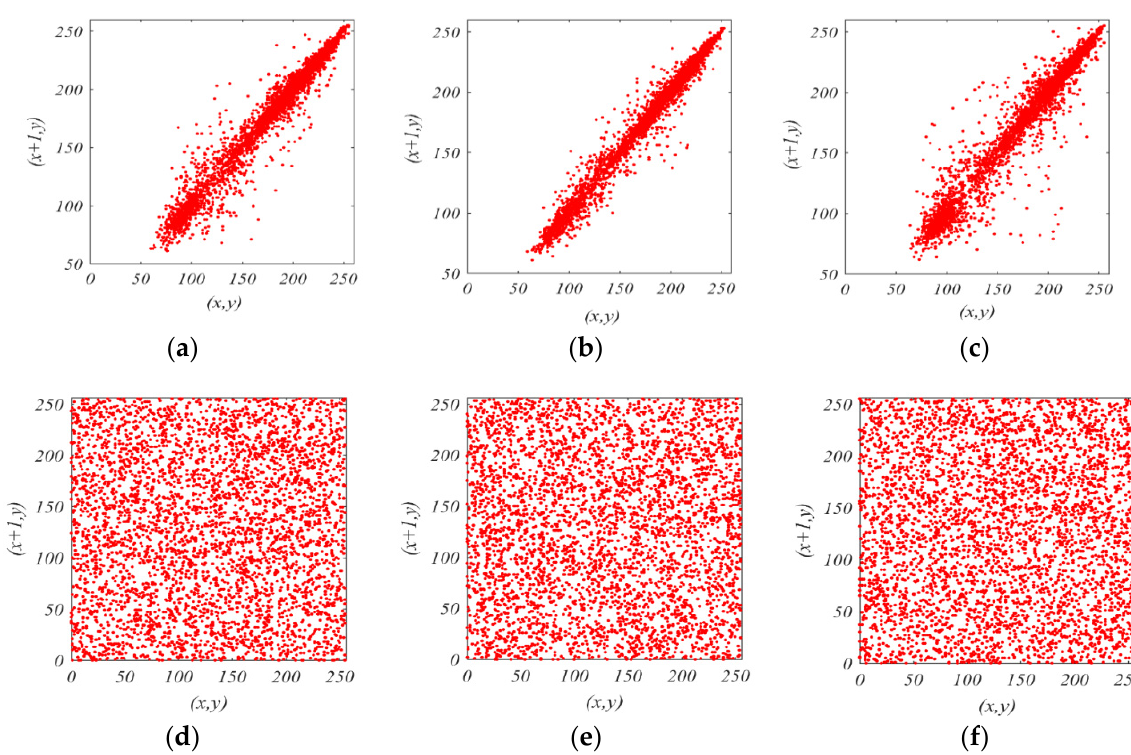
Figure 18. Correlation analysis of a plain Lena image and its consistent encrypted image: ( a , d ) horizontal correlation, ( b , e ) vertical correlation, ( c , f ) diagonal correlation.